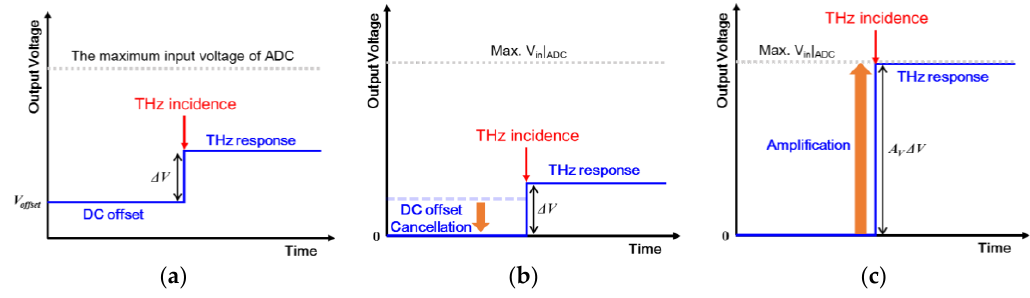
Figure 6. DC offset cancellation and output signal amplification in digital domain: ( a ) An output voltage of the detector pixel before DC offset cancellation; ( b ) An output voltage of the same pixel after cancellation; ( c ) An output voltage with gain control of the amplifier in the signal conditioning block.